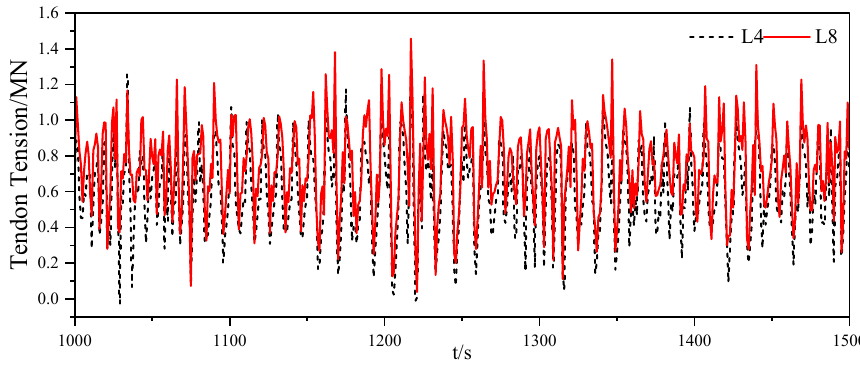
Figure 25. Tendon tension of L4 and L8.